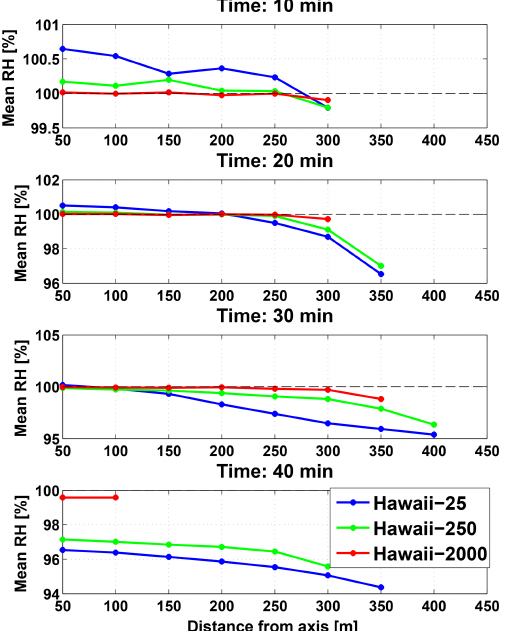
Figure 4. Four snapshots of horizontal cross-sections of RH (%; see panel titles for times). Panels include the results of different aerosol concentrations (see legend). Cross-sections are obtained by taking the mean RH of all vertical levels for each horizontal distance from the cloud center